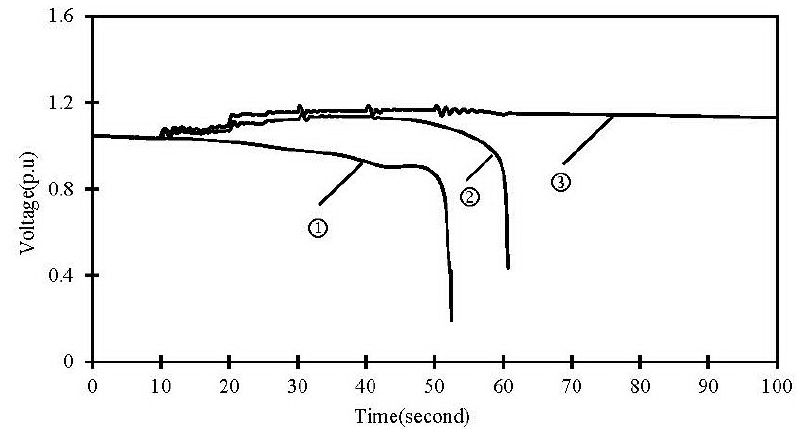
Figure 10. Voltage curve of key bus Liaoyang.